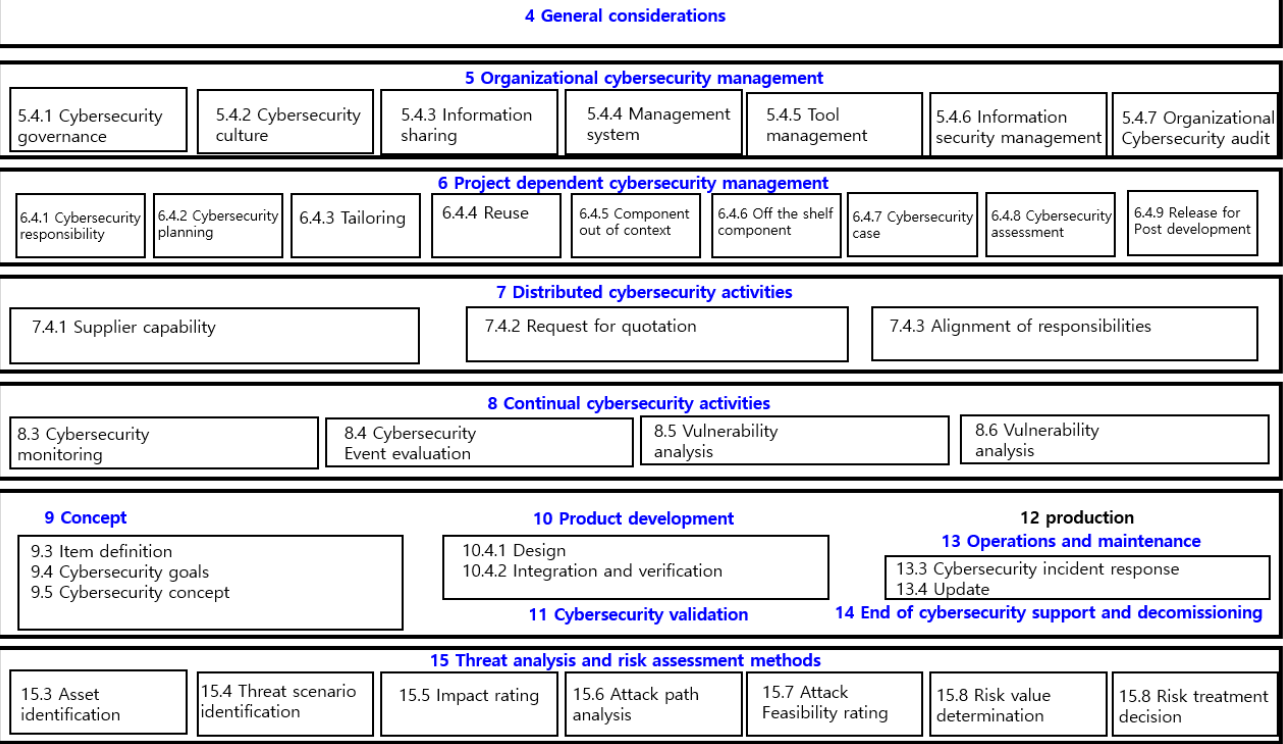
Figure 3. ISO/SAE 21434 Overall Composition (Source: ISO 21434 WG6, 2020).